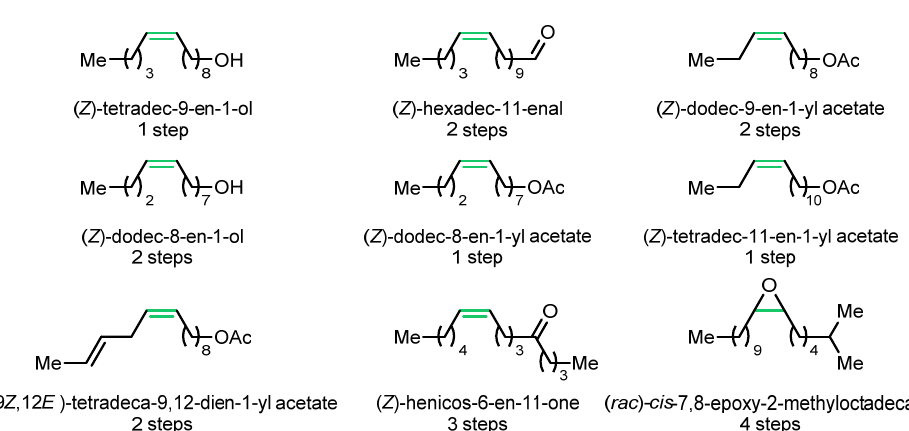
Figure 16. Lepidopteran insect pheromones synthesized by Grubbs and coworkers. Bonds formed by OM are highlighted.